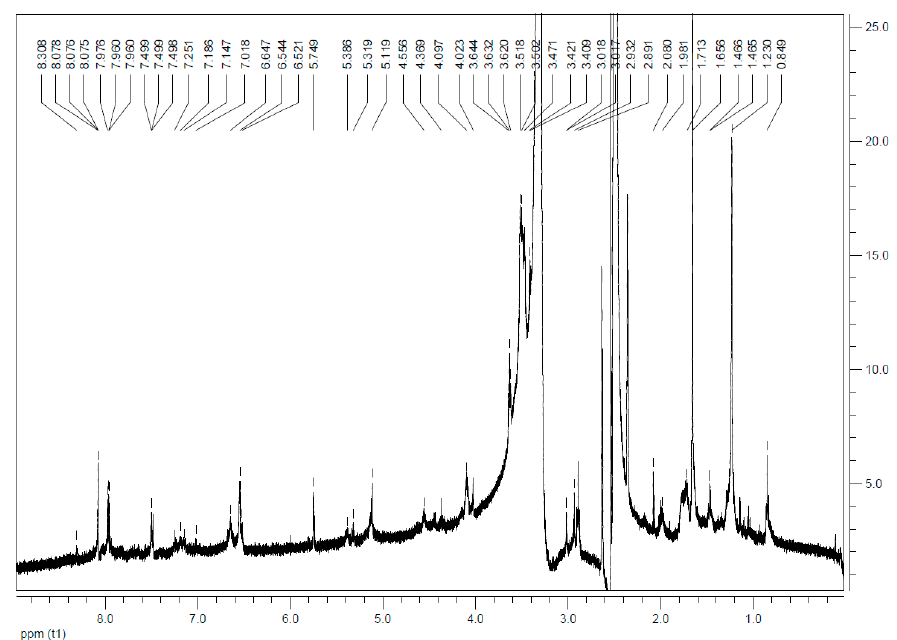
Figure A15. 1 H NMR spectrum of AuNP-RGD-NIR-dye 8 in d 6 -DMSO: typical signals of peptide- bond-NH (7.50 ppm), Phe-CH arom (7.25–7.02 ppm), Arg-C=NH (6.65 ppm), Arg-NH 2 (5.75 ppm), Phe-CH (5.39 ppm), Asp-CH (5.32 ppm), Arg-CH (4.56 ppm), Lys-CH (4.37 ppm), Gly-CH 2 (4.02 ppm) and NIR-dye 8.08 (d, 2H, 6,6 ′ -H), 8.05 (s, 2H, 4,4 ′ -H), 7.96 (t, 2H, β , β ’-H), 7.50 (m, 1H, δ -H), 7.3 (d, 2H, 7,7 ′ -H), 6.65 (t, 2H, γ , γ ’-H), 6.54 (d, 2H, α , α ’-H), 4.09 (t, 4H, 2 × >NCH2) (compound 4a in [51]) can be